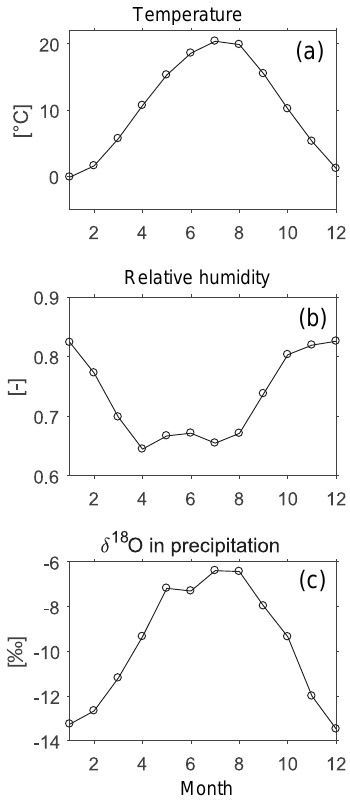
Figure 3. Long-term mean monthly air temperature (a) , relative hu- midity (b) and oxygen isotopic composition in precipitation (c) for the station Vienna Hohe Warte,